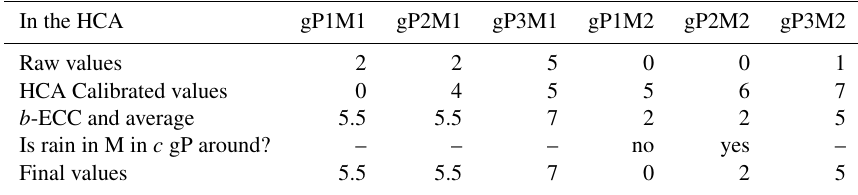
Table 3. Example of bc-ECC ( b = ∞ , c = 1) for a two-member (M) ensemble in a three-grid-point (gP) linear HCA. In the HCA gP1M1 gP2M1 gP3M1 gP1M2 gP2M2 gP3M2 Raw values 2 2 5 0 0 1 HCA Calibrated values 0 4 5 5 6 7 b -ECC and average 5.5 5.5 Is rain in M in c gP around? – – – no yes – Final values 5.5 5.5 7 0 2